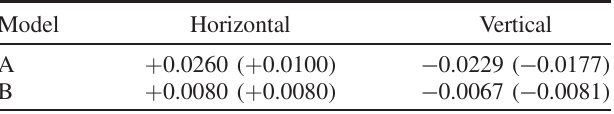
TABLE II. Incoherent tune shifts calculated for SOLEIL in the 4 = 4 filling at a beam current of 500 mA. Numbers without brackets: piecewise integration. With brackets: analytical esti- mates [Eq. (3) for model A and Eq. (4) for model B,